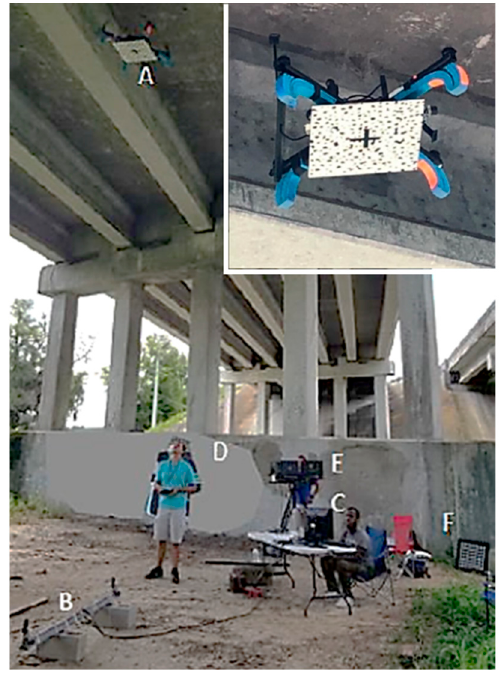
Figure 10. Experimental setup under the US 441 bridge, Alachua, FL. The photograph shows the drone ( A ), DIC stereo cameras mounted on a beam ( B ), computer for DIC image acquisition( C ), pilot ( D ), ground station ( E ), and DIC calibration grid ( F ).